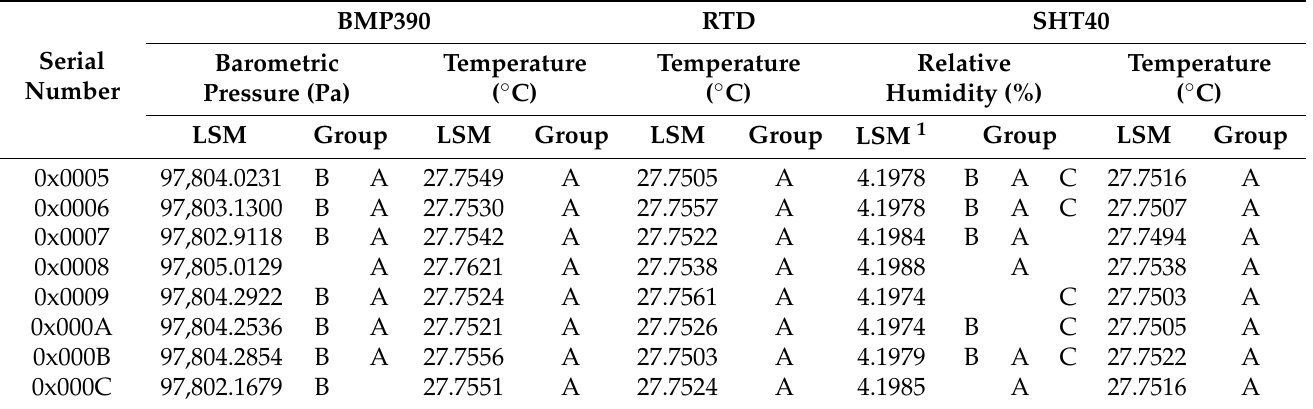
Table 13. Tukey-Kramer grouping for least-squares means (LSM) of PTH probe sensors during validation run. Within a column, LSMs with the same letter are not statistically